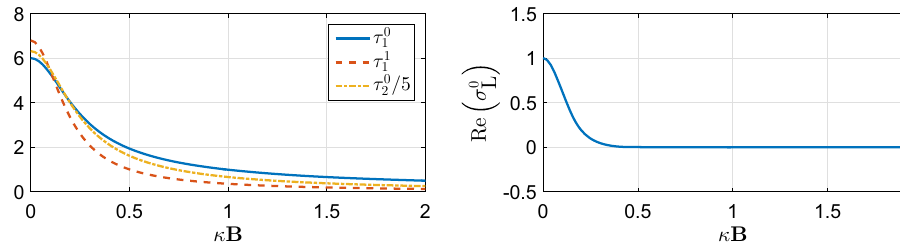
(cid:20) (cid:19) σ 0 as a function of κ B L